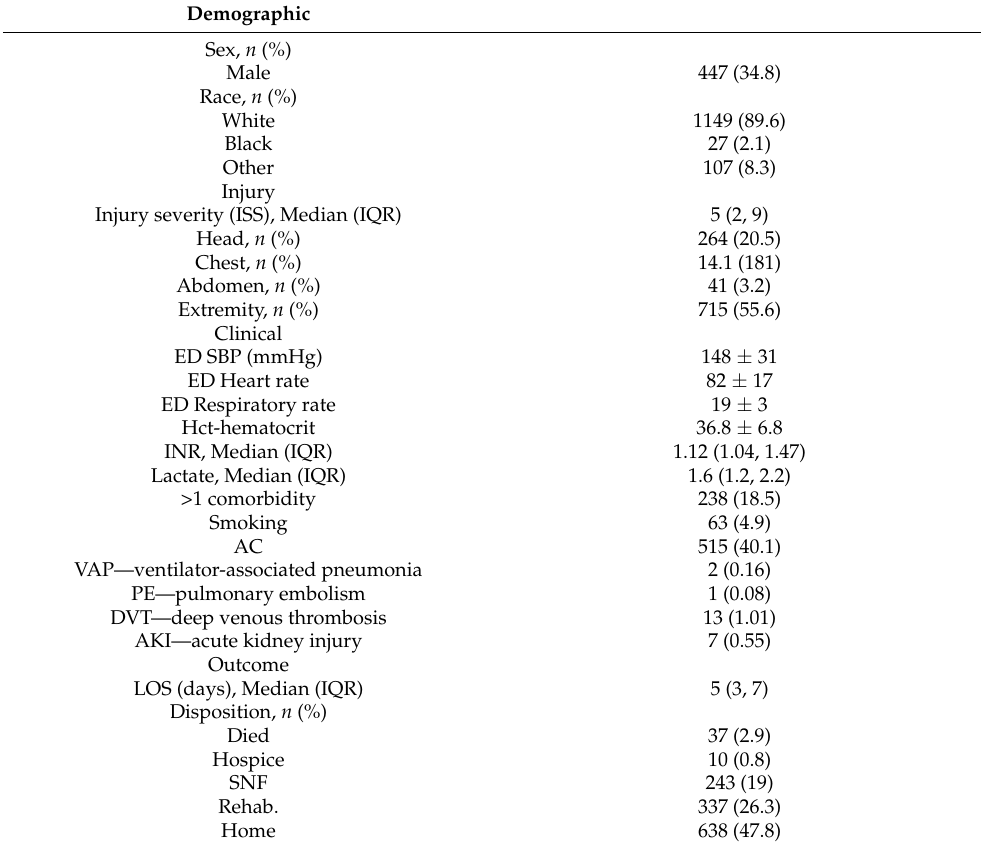
Table 1. Demographic, injury, clinical characteristics and outcomes of geriatric patients with low- energy blunt trauma, N =